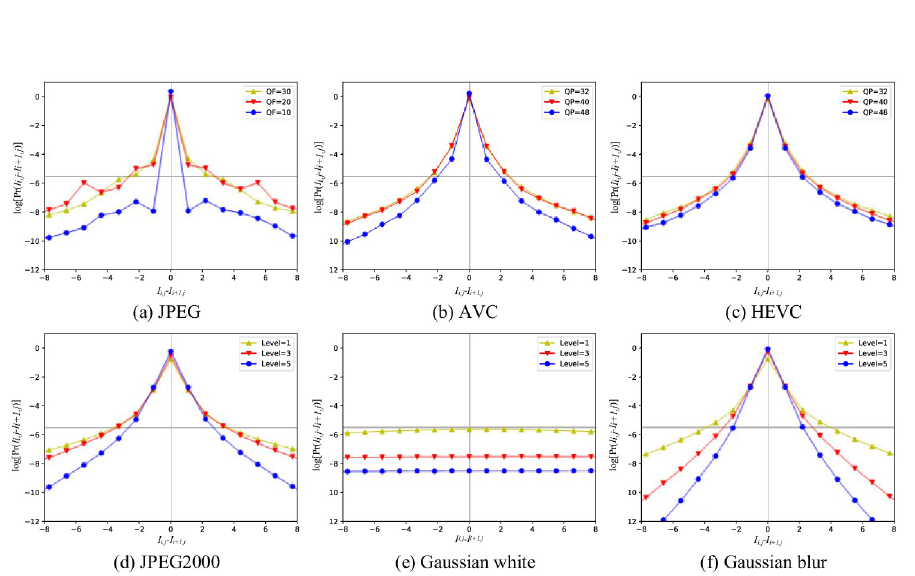
Fig 4. The probability distribution of pixel difference I i , j − I i +1, j under different distortion levels of each distortion type. (a) JPEG. (b) AVC. (c) HEVC. (d) JPEG2000. (e) Gaussian white. (f) Gaussian blue.